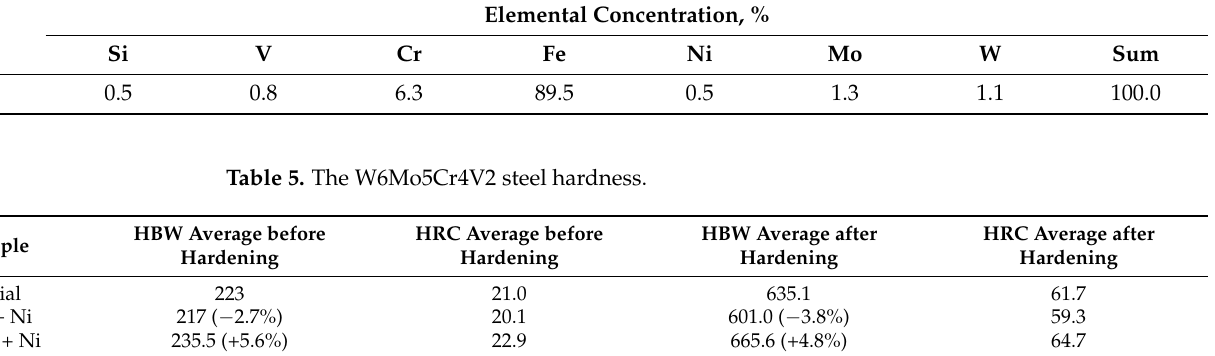
( Figure 10. The structure of W6Mo5Cr4V2 steel with channel elements after dynamic alloying in the SDP mode by SiC + Ni stream and subsequent hardening. ( a ) Microstructure of W6Mo5Cr4V2 steel with channels; ( b ) channel elements (fibers). Figure 11 and Table 4 show the qualitative and quantitative analysis of the channel element. The analysis confirms the presence of powder stream SiC + Ni residues in the channel element.